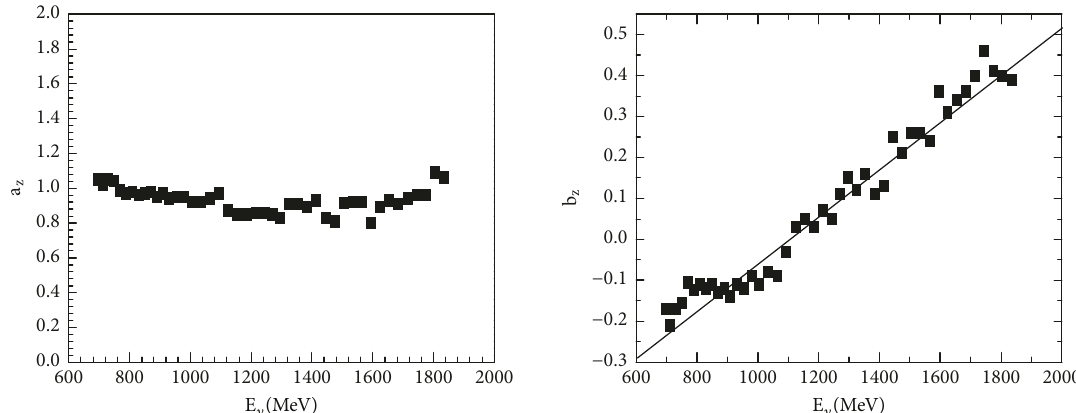
Figure 8: 𝑎 𝑍 and 𝑏 𝑍 for different bins of incident photon energy E 𝛾 . The symbols are the values taken in Figures 1–3. The straight line is a fitted curve.